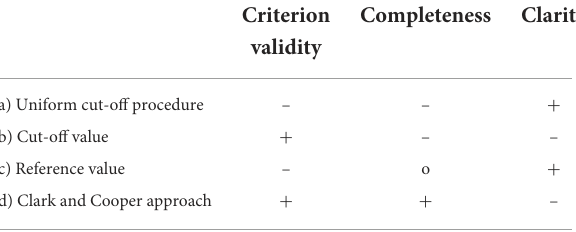
TABLE 1 Quality evaluation of methodological approaches to psychosocial risk